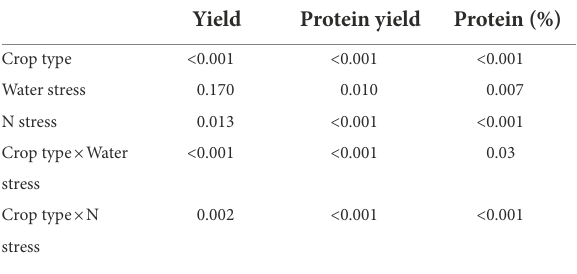
TABLE 2 Analysis of variance for grain yield, protein yield, and protein